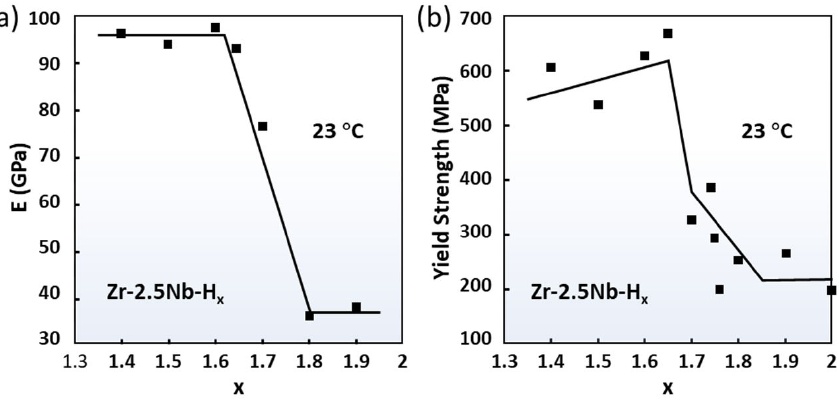
Figure 9. The Young’s modulus ( a ) and yield strength ( b ) of ZrH x [118]. Reprinted with permission from [118]; Copyright 2005 Elsevier.